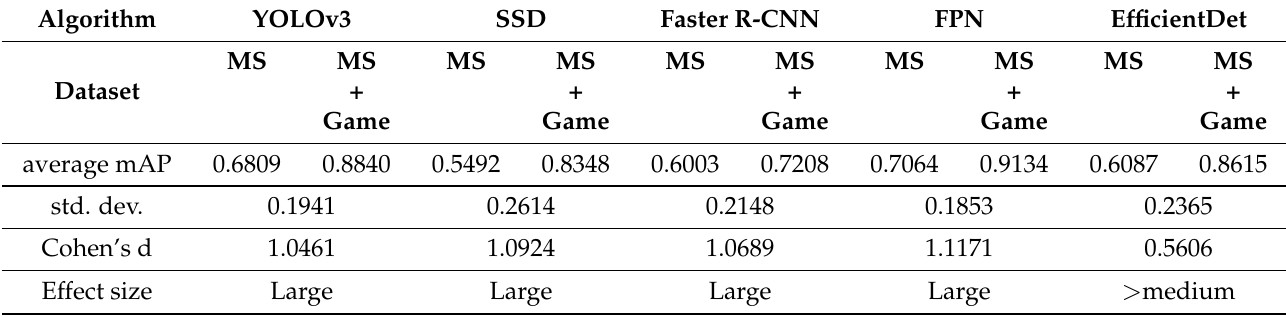
Table 11. Cohen’s d values for mAPs from five object detection algorithms. We compared the algorithms trained by MS COCO and retrained by MS COCO with game scenes. Note that MS COCO is abbreviated as MS in the table.